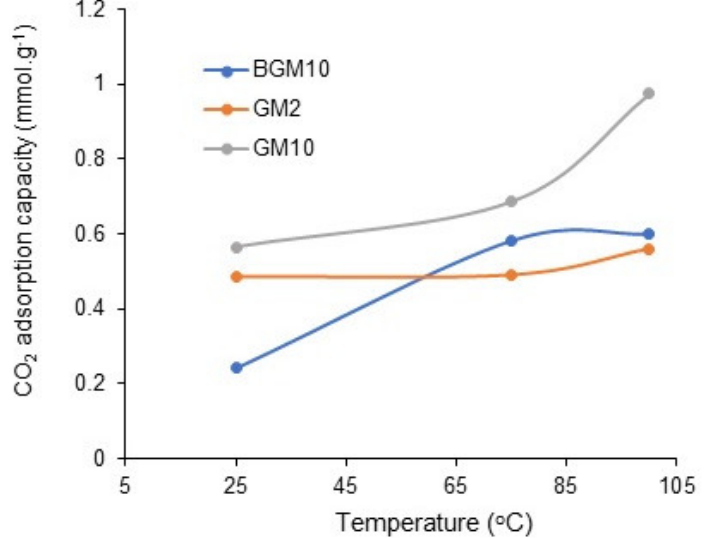
Figure 10. The CO 2 adsorption capacities of BGM10, GM10, and GM2 composites at different tem- perature .